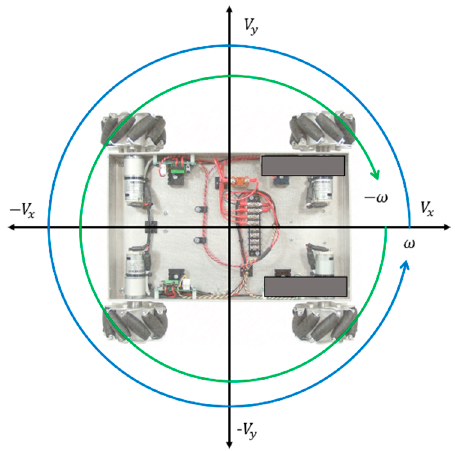
Figure 11. Pet-Bot control factors.